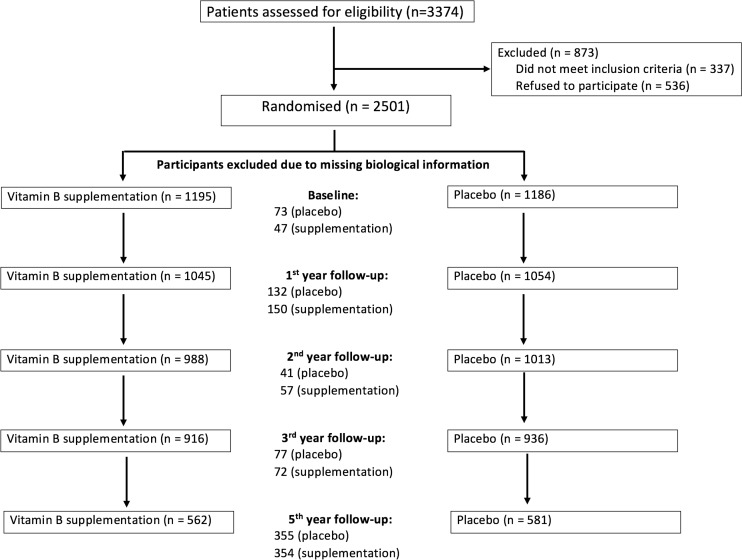
Flowchart describing study participant selection for randomization and causes of exclusion throughout the 5 years.